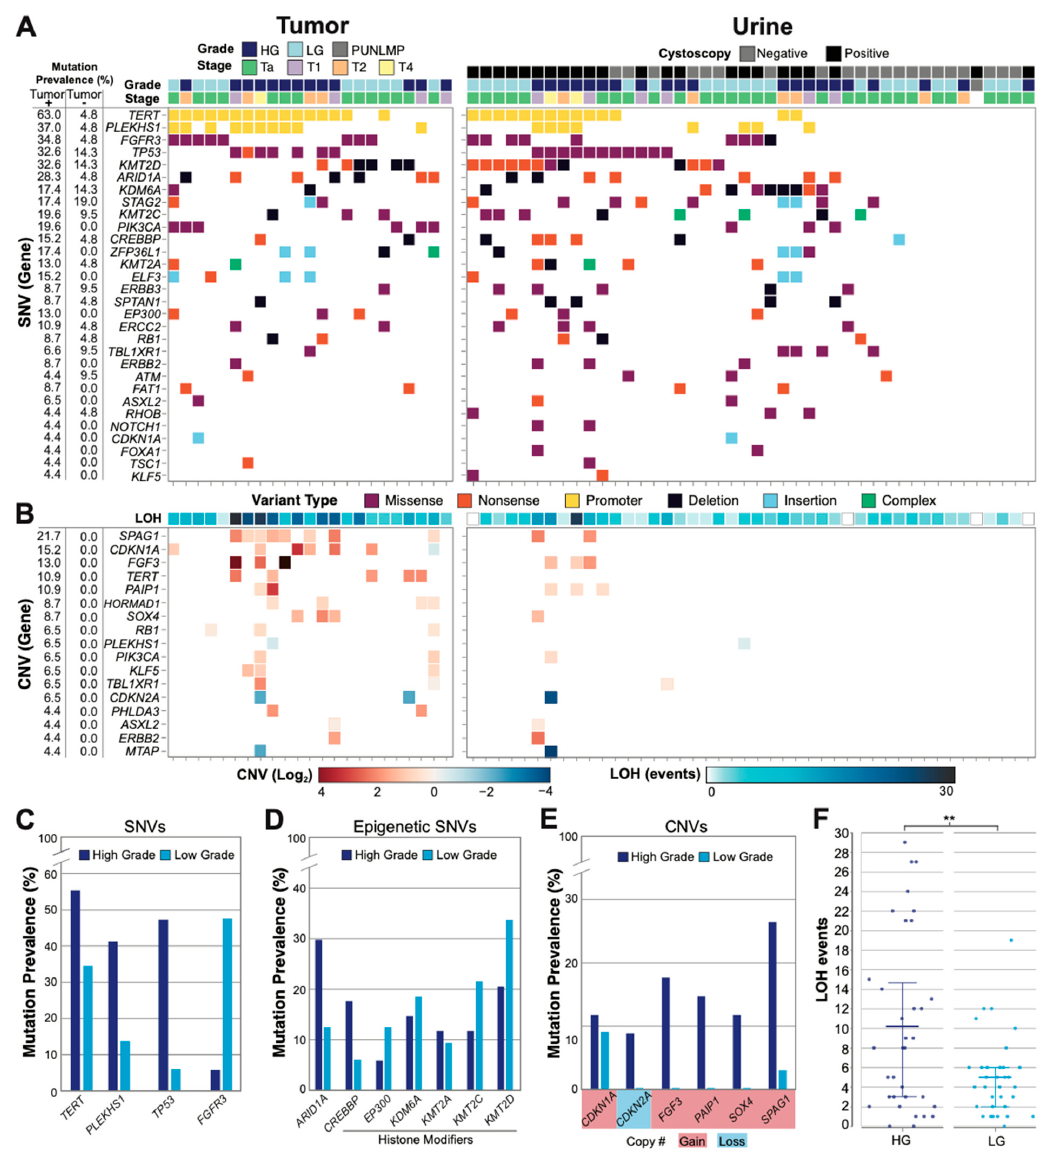
Figure 2. Genomic profile of the urothelial carcinoma cohort. ( A ) Tumor (left, n = 23) and urine (right, n = 44) SNVs are illustrated for each patient sample with pathologic correlates (one column per patient). All genes mutated in >2.5% of tumor positive samples are shown. For urine samples, the cystoscopy status is color coded. Cystoscopy positive and negative urines are collected before and after tumor resection, respectively. ( B ) Significant CNV events (log2 fold change) and copy-neutral loss of heterozygosity (LOH) (total events) are shown. All CNV events present in >2.5% of tumor positive samples are shown. ( C ) Mutation prevalence in HG and LG disease are shown for the most frequently identified genes, genes that correlate with grade, and ( D ) genes responsible for epigenetic regulatory mechanisms. ( E ) Mutation prevalence of genes with most frequently observed CNVs, with gains or losses highlighted. ( F ) LOH events are plotted for HG ( n = 34) and LG ( n = 32) disease with mean and 25–75-percentiles highlighted (** p = 0.0367, Mann–Whitney U).